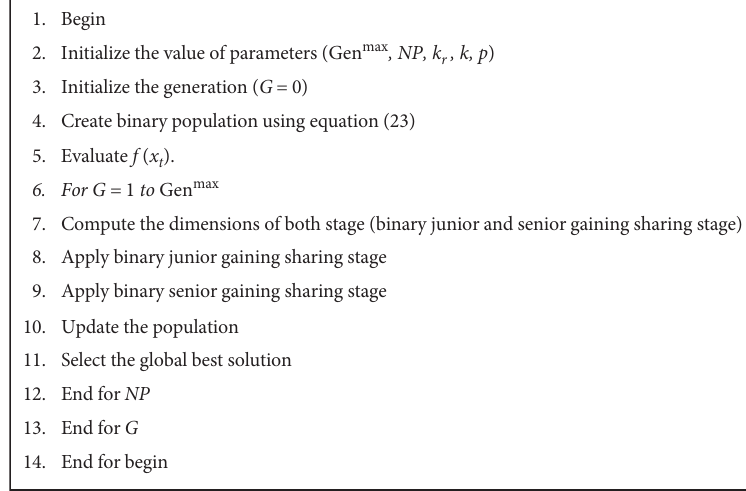
Figure 7: Pseudocode for BGSK. Table 10: Numerical values of parameters.